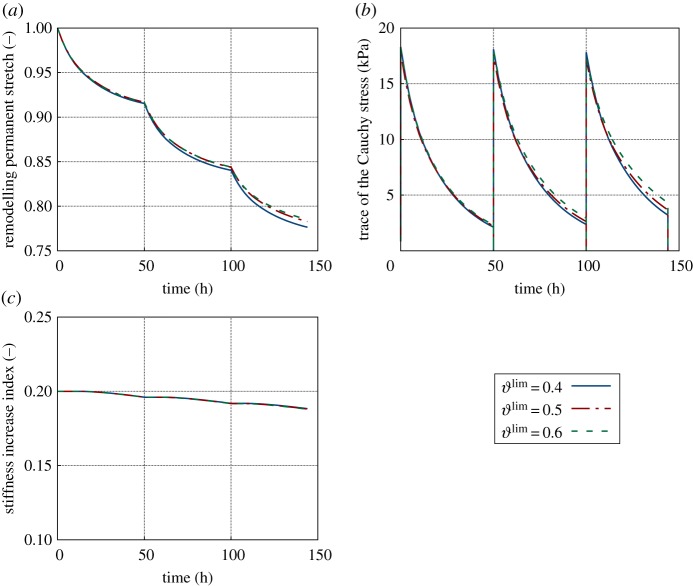
Remodelling permanent stretch, ϑ (a), trace of the Cauchy stress, tr σ (b) and stiffness increase index, Deff (c), at a representative Gauss point of the inner cavity wall. Evolution through three foam changes (at 0, 50 and 100 h) considering a remodelling permanent stretch limit ϑlim in the growth-limiting function f(ϑ) of 0.4, 0.5 or 0.6.